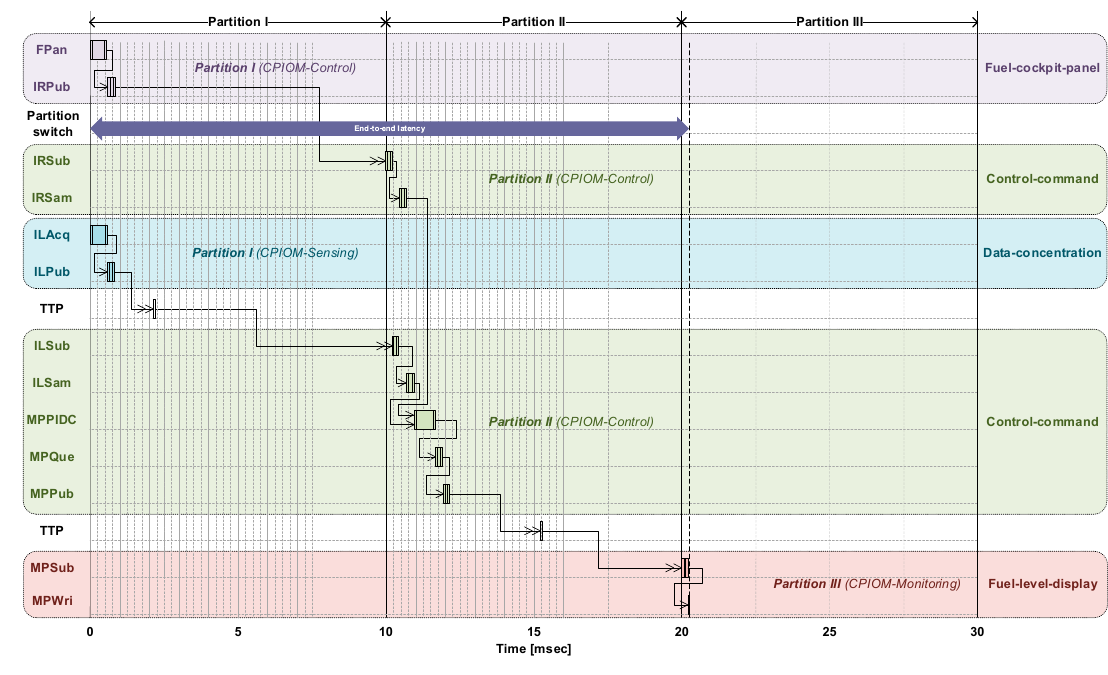
Figure 18. Scheduling strategy 2b of the FBs for the ITT control.